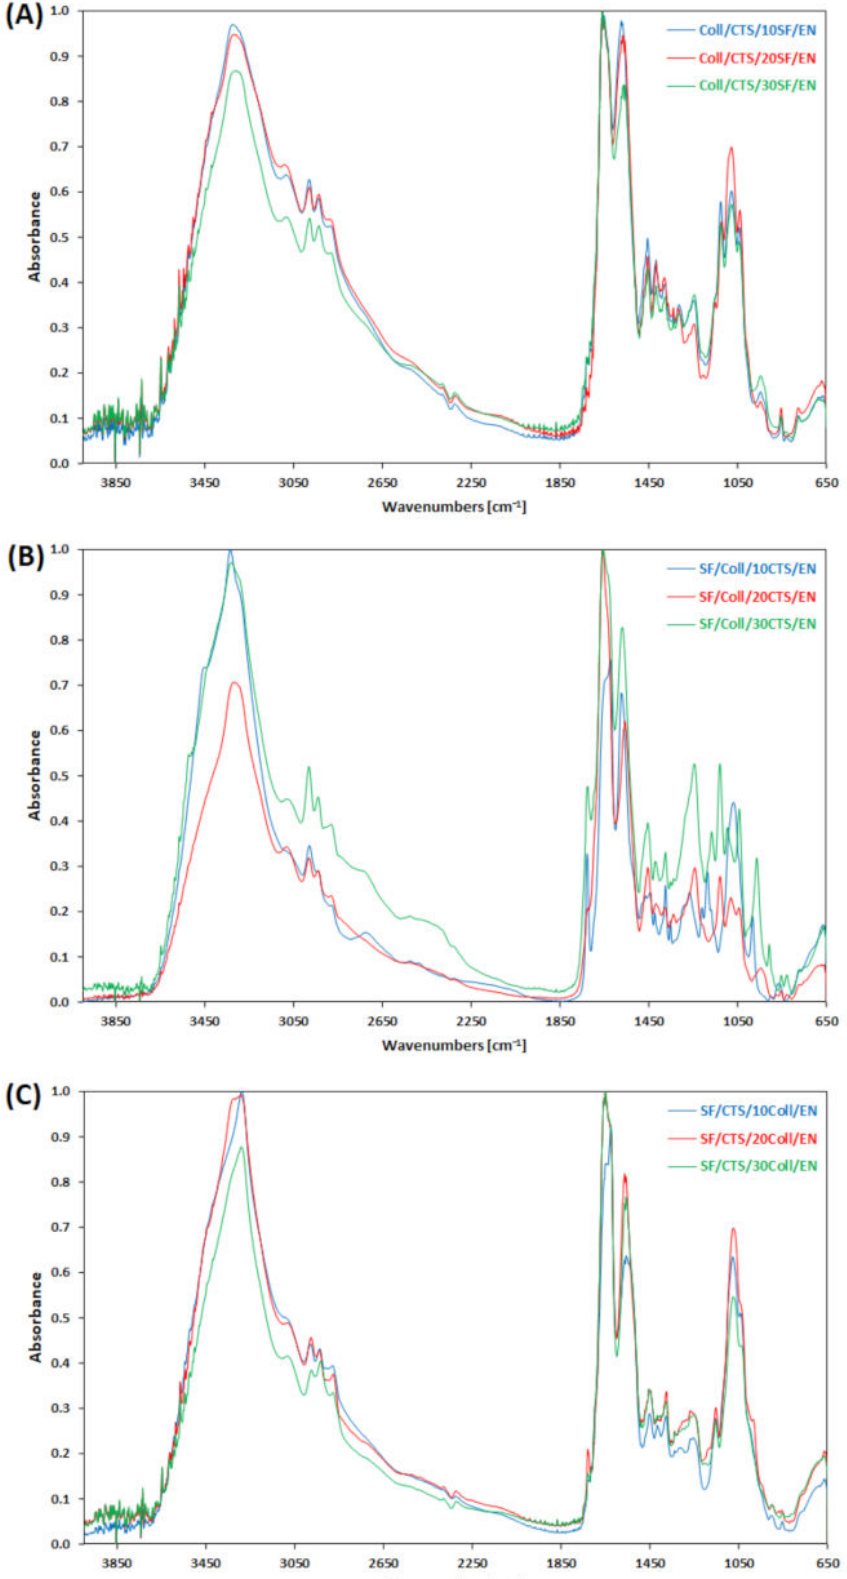
Figure 4. FTIR-ATR spectra of biopolymeric scaffolds: ( A ) 50/50 Coll/CTS mixtures with 10, 20, and 30% of SF; ( B ) 50/50 SF/Coll mixtures with 10, 20, and 30% of CTS; ( C ) 50/50 SF/CTS mixtures with 10, 20, and 30% of